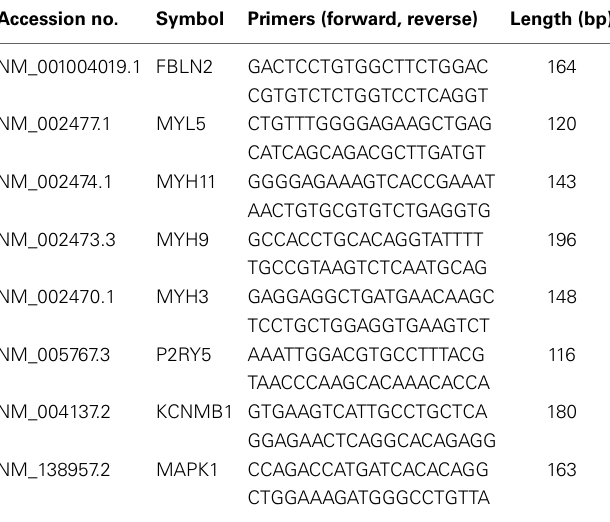
Table 2 | List of primers used in the qRT-PCR